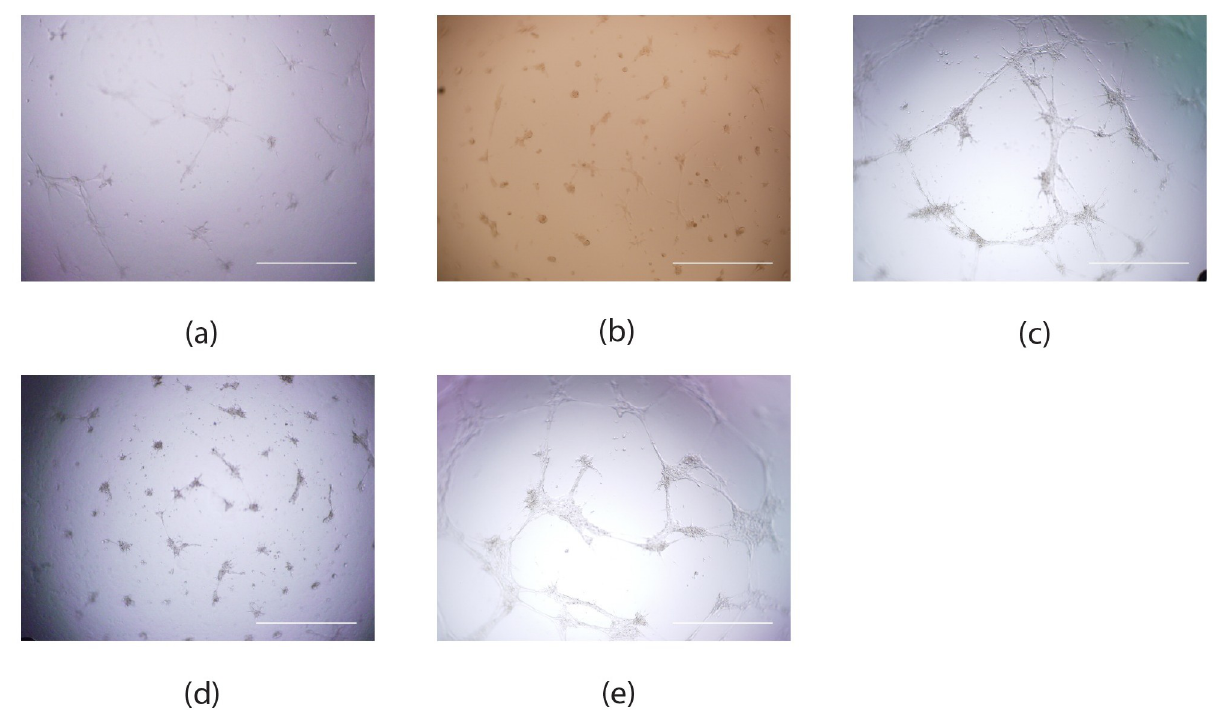
Fig 2. iEC tube formation after incubation on growth factor reduced Matrigel. (a) Neonatal-derived iECs; (b) Patient 1; (c) Patient 2; (d) Patient 3; (e) Patient 4, 24 hrs post seeding. Scale bars are 500 μ m.